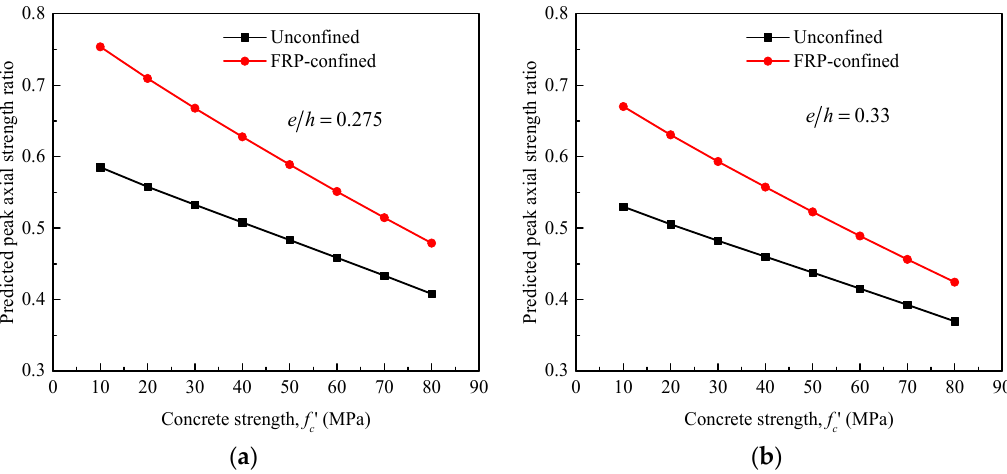
Figure 14. Predicted peak load ratios for unconfined and FRP-confined RC columns versus concrete strength: considering the effect of increased eccentricity ratio and concrete strength. ( a ) For e / h = 0.275 and ( b ) For For e / h = 0.33.